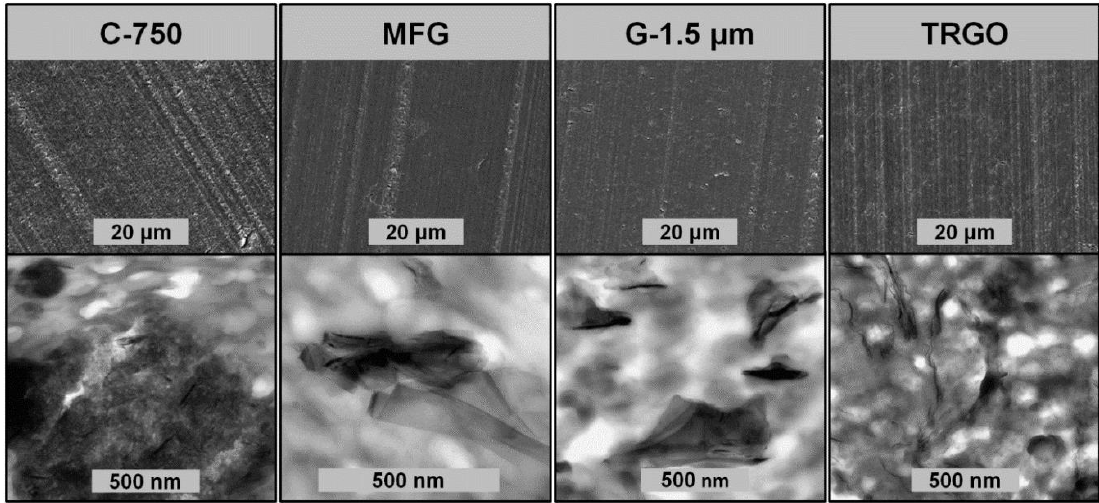
Figure 4. Morphology imaged by means SEM (above) and TEM (below) of carbon/ABS nanocomposites as a function of the filler type at a filler loading of 5 wt %.